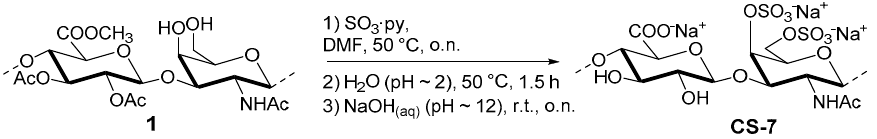
Figure 3. Scheme of the semi-synthesis of CS-7.